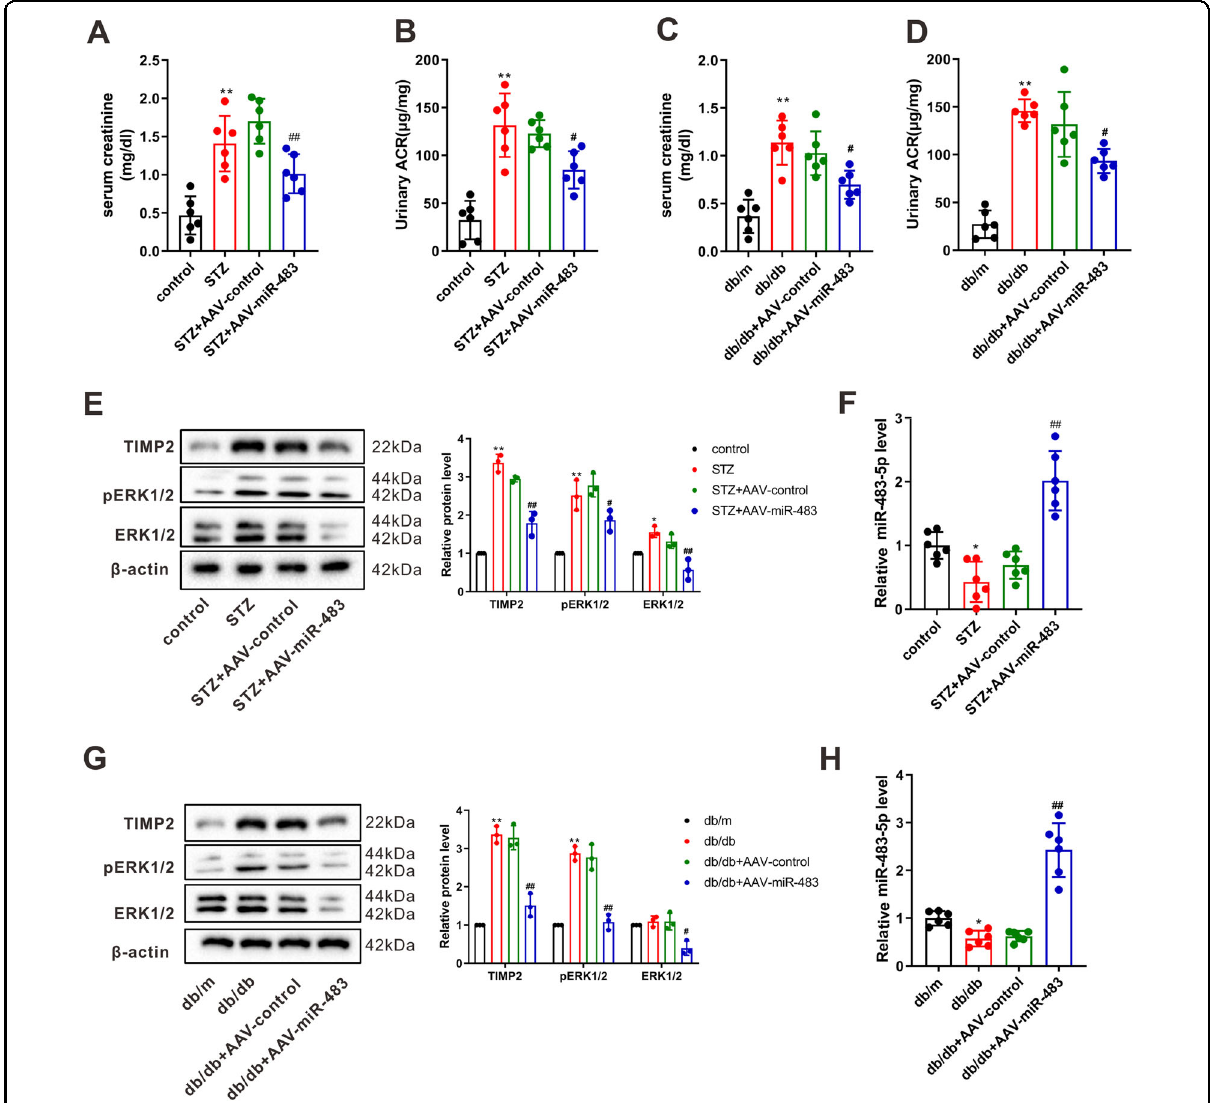
Fig. 5 Regulation of miR-483-5p on the renal interstitial fi brosis in type 1 and type 2 diabetic mice. A – D Detection of serum creatinine and urinary albumin to creatinine ratio concentrations by Creatinine Serum Detection Kit and urinary albumin to creatinine ratio assay kit. E – H Detection of TIMP2, ERK1/2, and miR-483-5p expressions by qRT-PCR and western blot. * P < 0.05, ** P < 0.01 vs. control or db/m. # P < 0.05, ## P < 0.01 vs. STZ + AAV-control or db/db + AAV-control. One-way ANOVA followed by Tukey ’ s or LSD post-test. STZ Streptozotocin, db/m db/misty, ACR albumin to creatinine